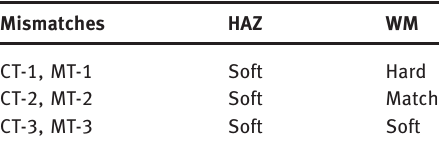
Table 1: Different mismatches in creep properties.